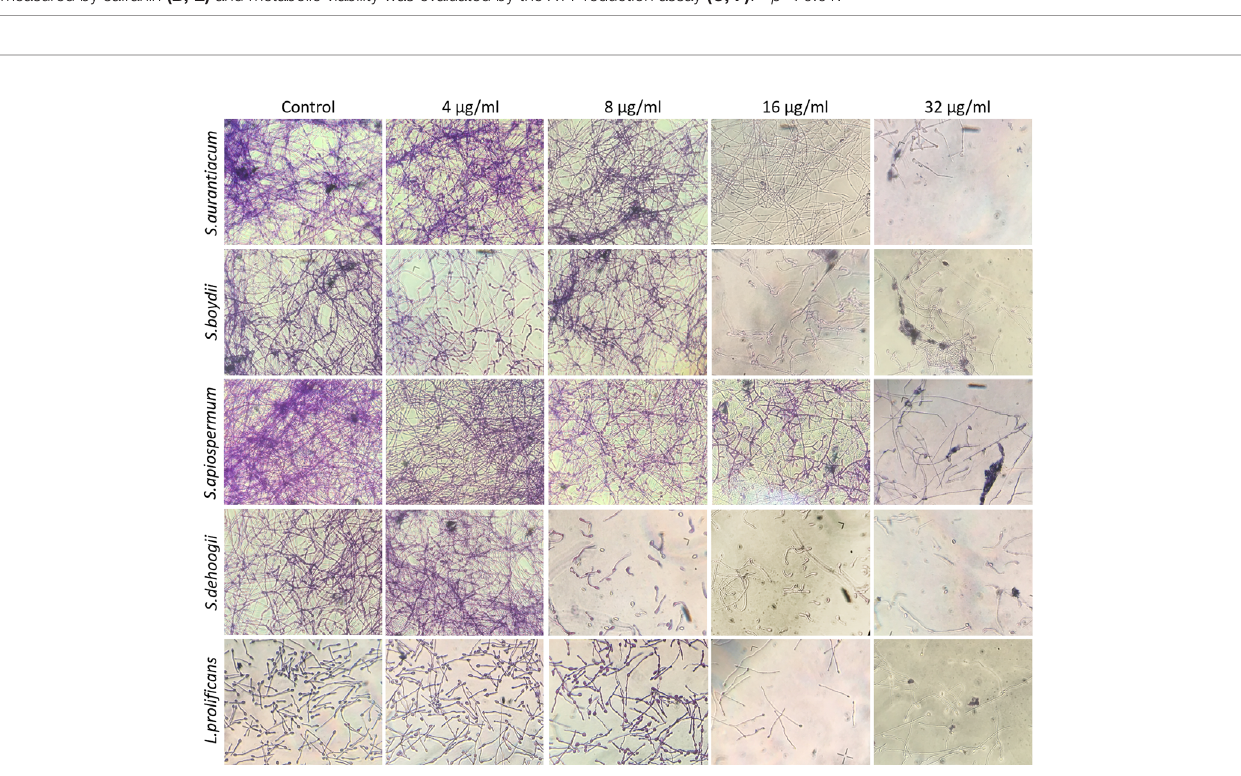
FIGURE 4 | Preformed biomass of Scedosporium aurantiacum , Scedosporium boydii , Scedosporium apiospermum , Scedosporium dehoogii and Lomentospora proli fi cans observed using a light microscope. Cells were grown in RPMI 1640 at 37°C for 24 h to form a fungal biomass and then a new 24-h incubation was performed in the absence (control) or the presence of 4, 8, 16 or 32 m g/ml of miltefosine. The fungal biomass was then stained with crystal violet and observed using a light